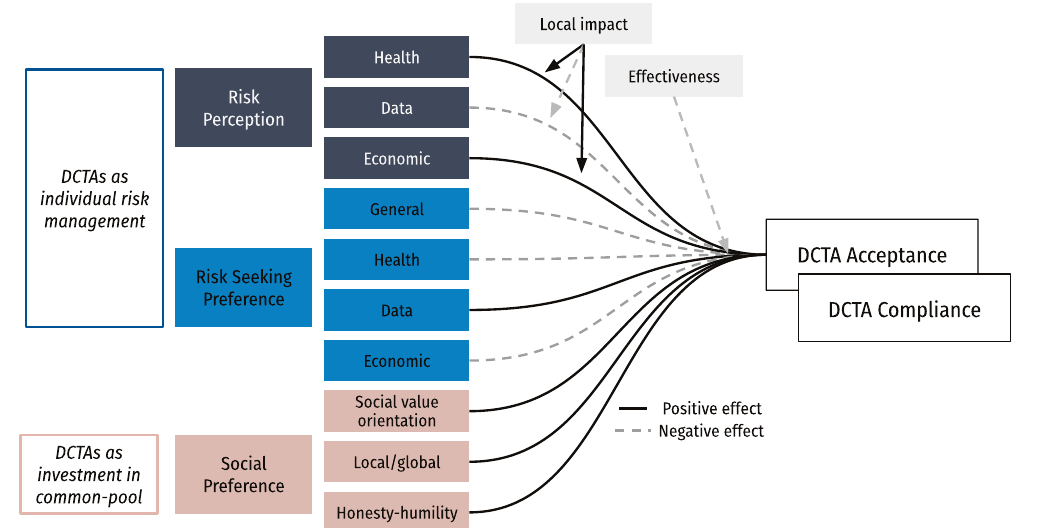
Fig. 1 Preregistered hypotheses. Predictions based on the individual and the societal perspective regarding the role of risk preferences, risk perceptions, and social preferences on digital contact-tracing application (DCTA)